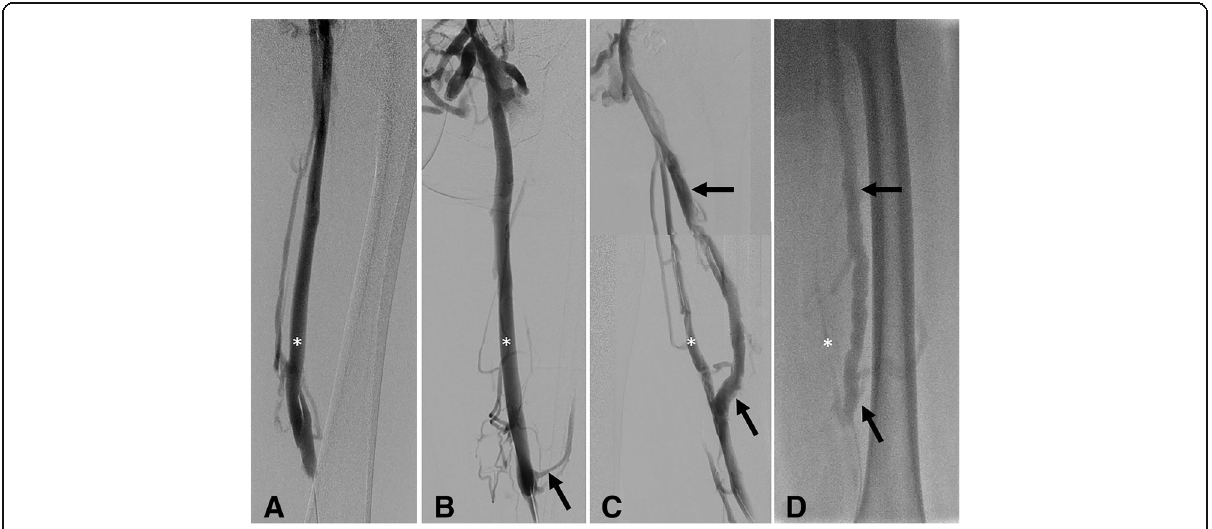
Fig. 2 Examples of grading of axial transformation of the deep femoral vein on conventional venography. a Grade 0, normal anatomy with no post-thrombotic changes. b Grade 1, a popliteal-deep femoral collateral connection (black arrow) and normal caliber deep femoral vein. c Grade 3, the deep femoral vein (black arrows) is larger than the obstructed femoral vein. d Grade 4, large caliber deep femoral vein (black arrows) and occluded femoral vein. White * indicates the femoral